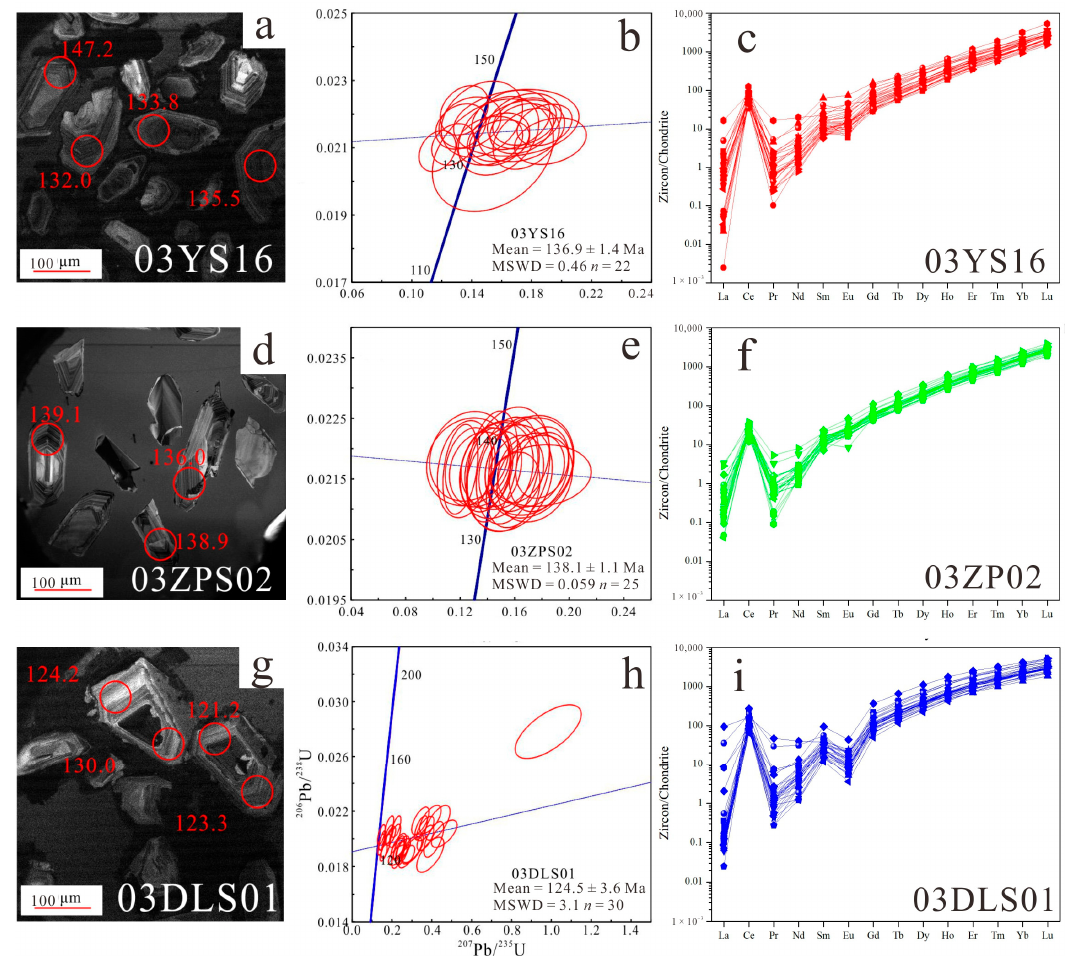
Figure 8. CL images, concordia diagrams and REE patterns of zircon grains from the Yueshan ( a – c